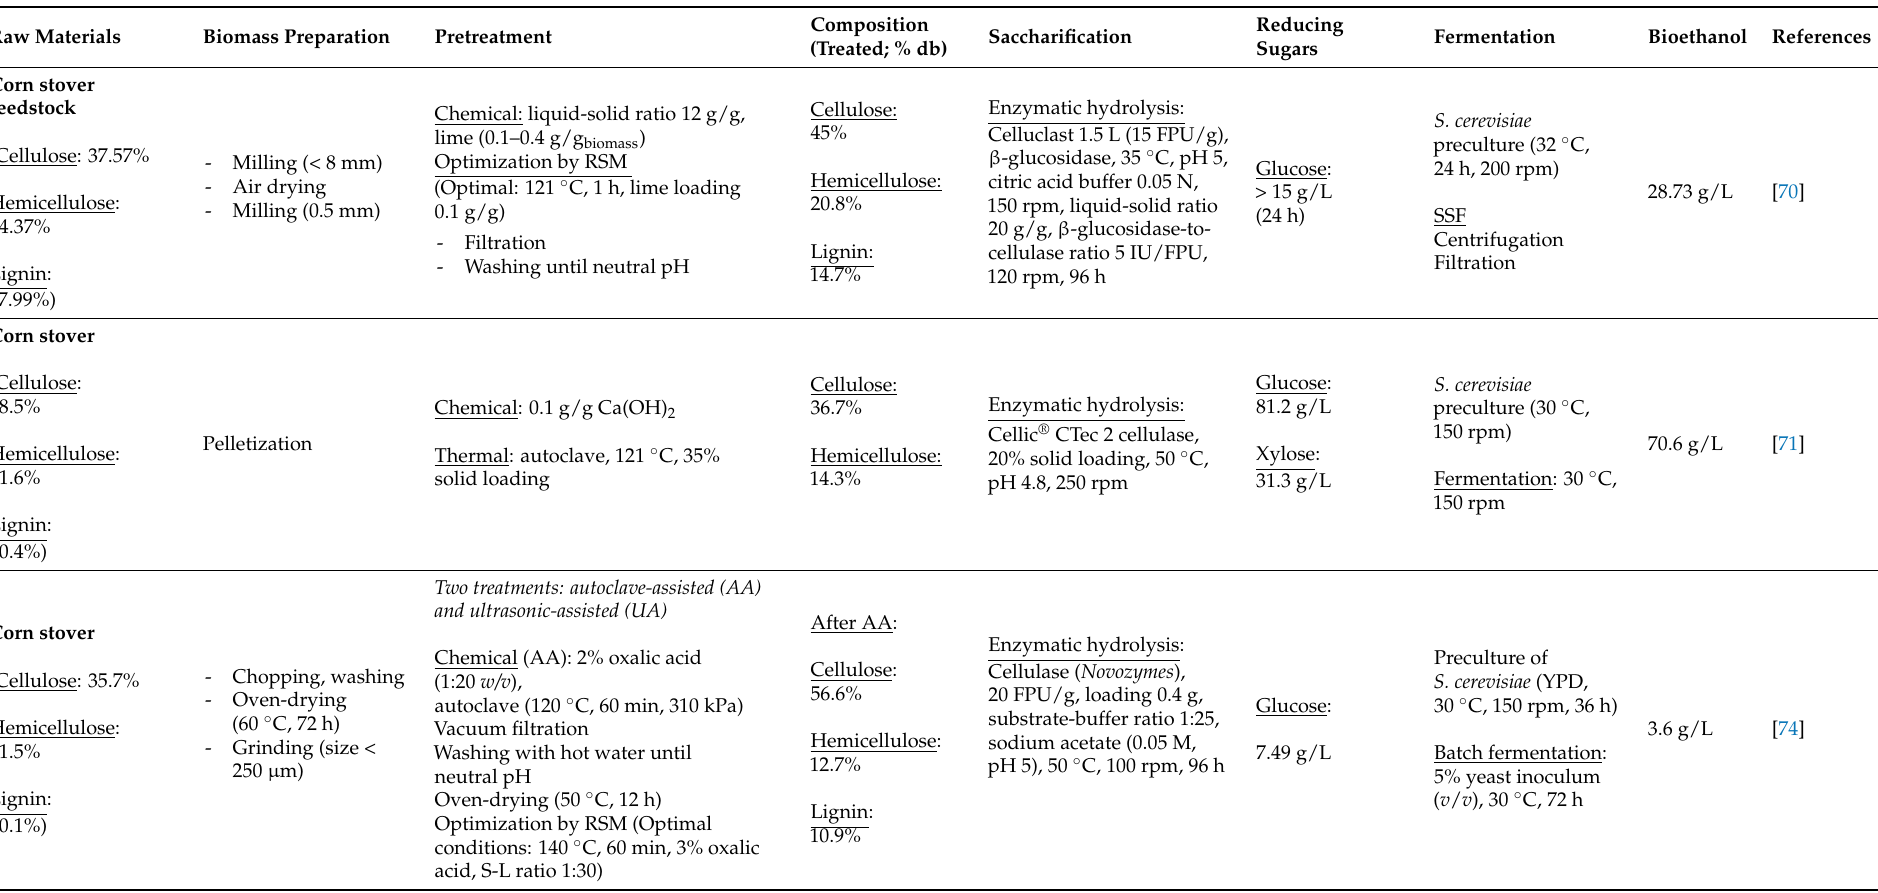
Table 3. Summary of recent experiments done for pretreatment corn